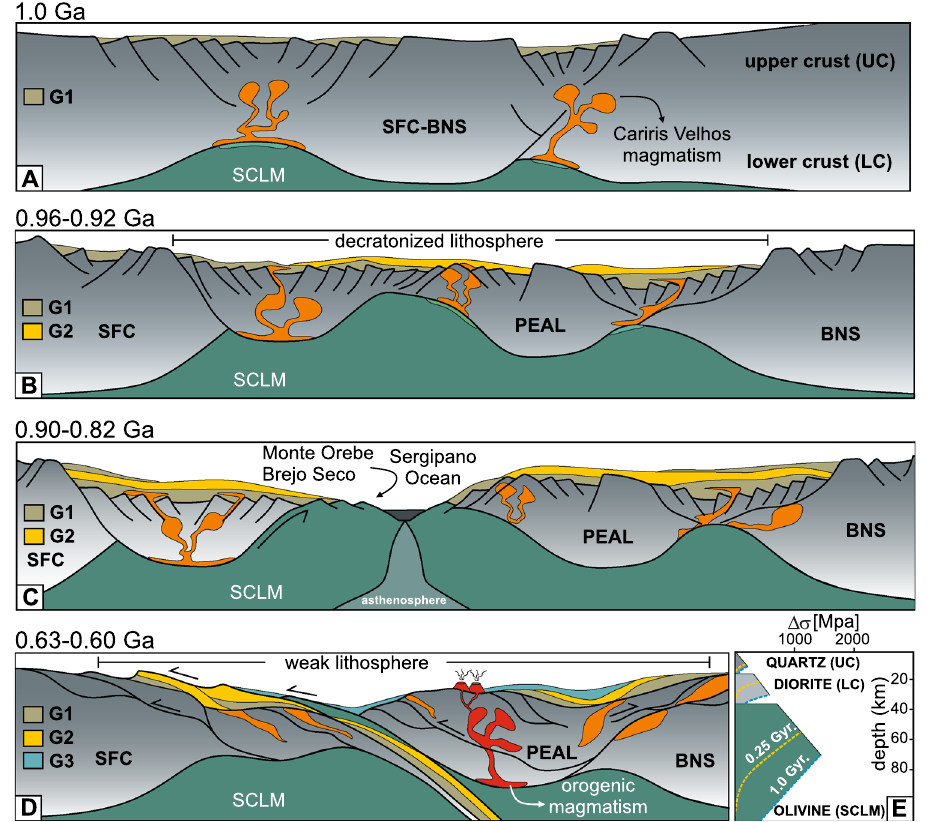
Figure 5. Tectonic evolution and formation of the northern São Francisco passive margin. ( A ) Initial extension and partial melting of the sub-continental lithospheric mantle (SCLM) generating mafic magmas associated with the early Cariris Velhos granitoids and filling of depocenters with sediments shed by cratonic sources (G1 pattern of detrital zircon ages in Fig. 3). ( B ) Continuous extension and necking of the cratonic lithosphere associated with intrusion of late Cariris Velhos granitoids, extrusion of volcanic rocks and sedimentation of strata derived from erosion of Cariris Velhos magmatic rocks as well as cratonic rocks (G2 pattern of detrital zircon ages in Fig. 3). ( C ) Breakup of the cratonic lithosphere and formation of the PEAL continental ribbon and separation of the Benino-Nigerian Shield ( BNS ). This stage marks development of the São Francisco Craton passive margin accompanied by marginal mafic–ultramafic rocks of the Brejo Seco 14 and Monte Orebe 29 units interpreted as exhumed sub-continental lithospheric mantle. At this stage the margin is supplied by mixture of detrital material from the craton and Cariris Velhos magmatism. ( D ) Inversion of the passive margin basin and initial collision of the São Francisco Craton against the PEAL. At this stage sedimentary strata are dominated by Brasiliano-age orogenic detritus as well as detritus from the older sequences (G3 pattern of detrital zircon ages in Fig. 3). ( E ) Yield stress envelope 54 for continental lithosphere as a function of the time since the last thermotectonic event (1.0 Ga: dashed blue lines) and (0.25 Ga: dashed yellow lines, corresponding approximately to the time gap between Tonian extension and start of the orogeny in the BP). The stress envelopes show that during the Brasiliano orogenic event, the cratonic area would be stronger than the regions that underwent the more recent Tonian thermotectonic event. This implies that the orogenic deformation would focus on the weaker decratonized